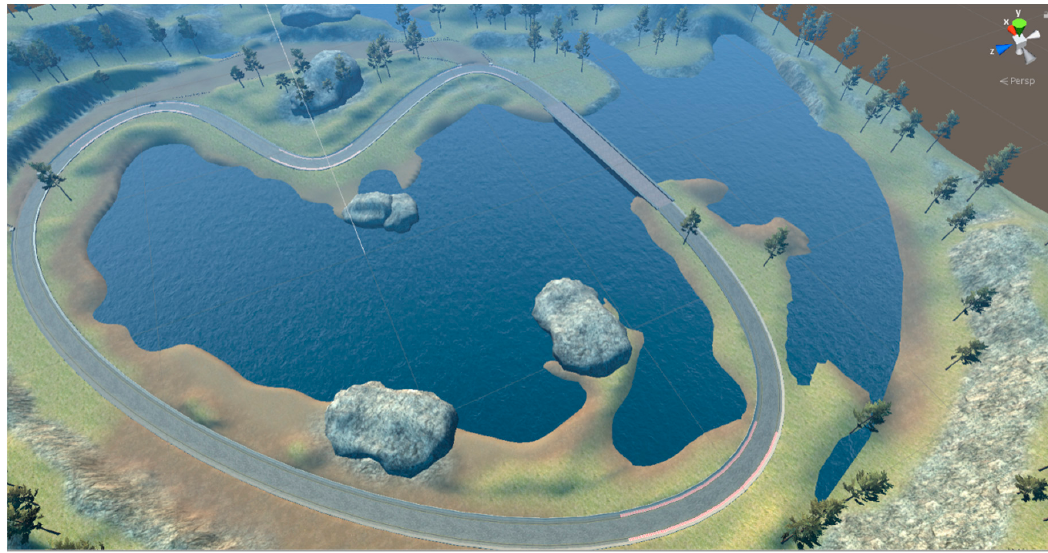
Figure 6. Top view of the scene in Unity editor for the self-driving car simulator [7].